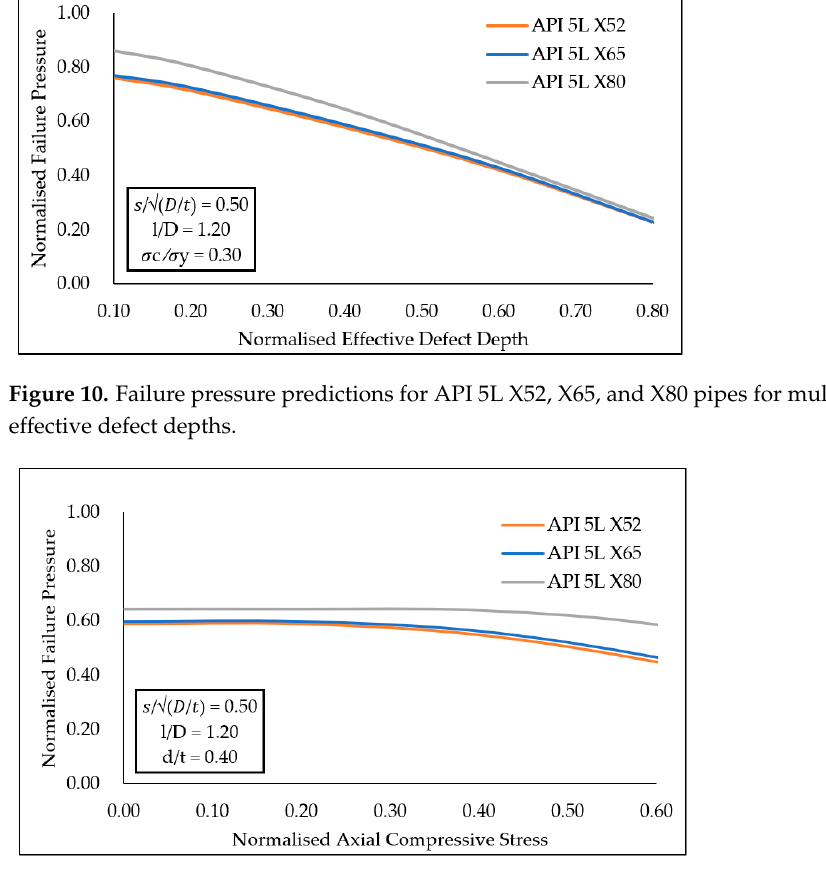
Figure 11. Failure pressure predictions for API 5L X52, X65, and X80 pipes for multiple normalised axial compressive stress.